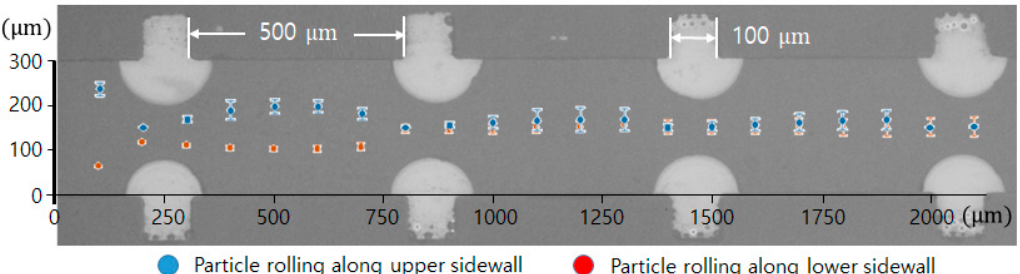
Figure 6. Trajectory of microsphere movement over the air bubbles in the catheter channel.